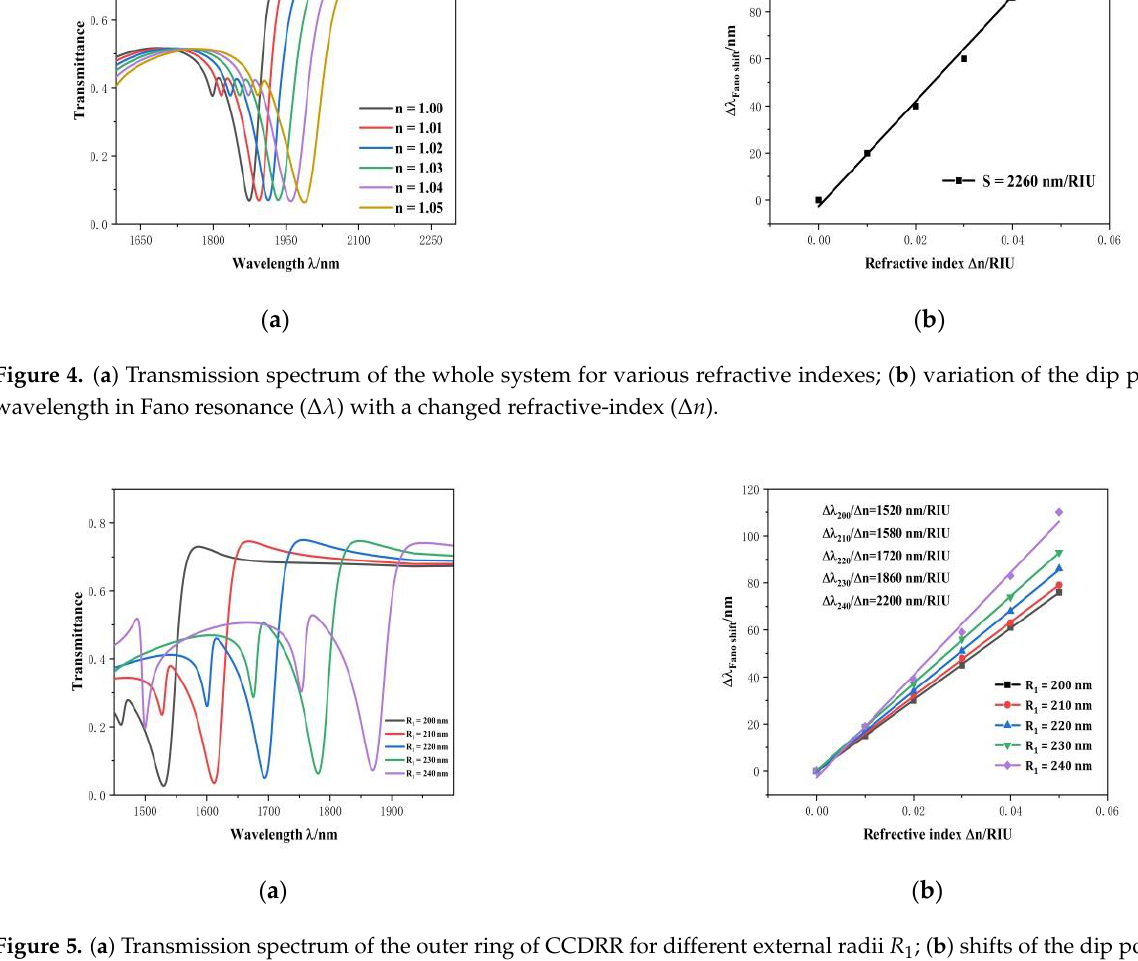
Figure 5. ( a ) Transmission spectrum of the outer ring of CCDRR for different external radii R 1 ; ( b ) shifts of the dip point in Fano resonance ( Δλ ) with a changed refractive-index ( Δn ).